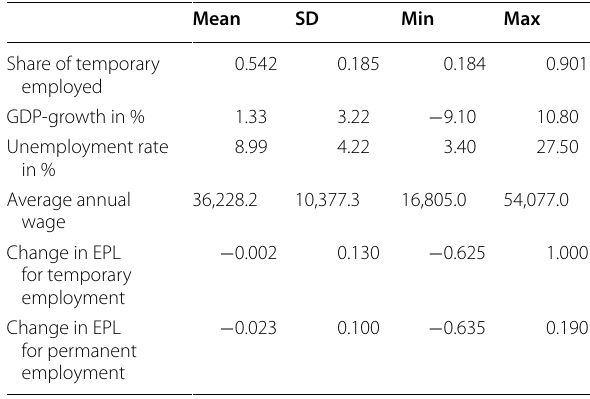
Table 1 Summary Statistics. Source Eurostat LFS (2016), Eurostat Database (2016) and OECD.Stat (2016), own cal-